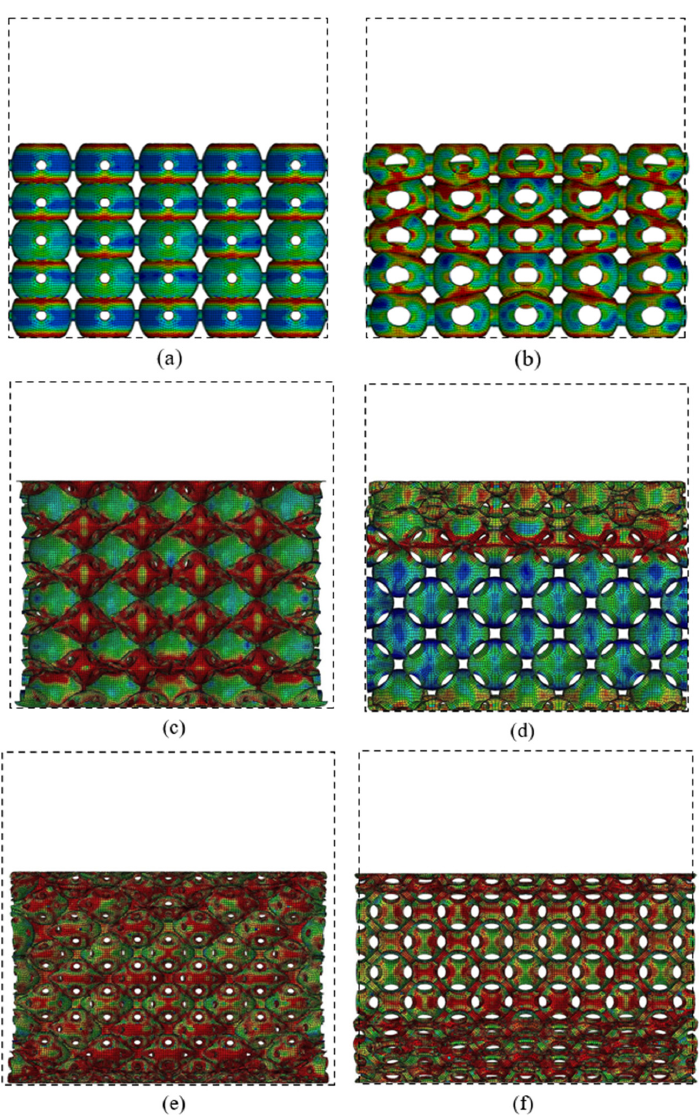
Figure 13. Deformations of SC structure with the ( a ) smallest and ( b ) largest hole diameters at a strain of 38%; deformations of BCC structure with the ( c ) smallest and ( d ) largest hole diameters at a strain of 28%; deformations of FCC structure with the ( e ) smallest and ( f ) largest hole diameters at a strain of